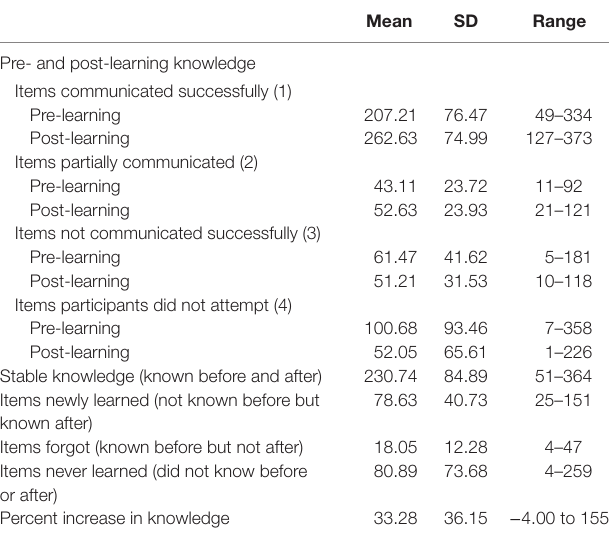
Table 3 | Learners’ success in acquiring items and phrases through the Specific-Purpose English Communication System for Seniors curriculum.